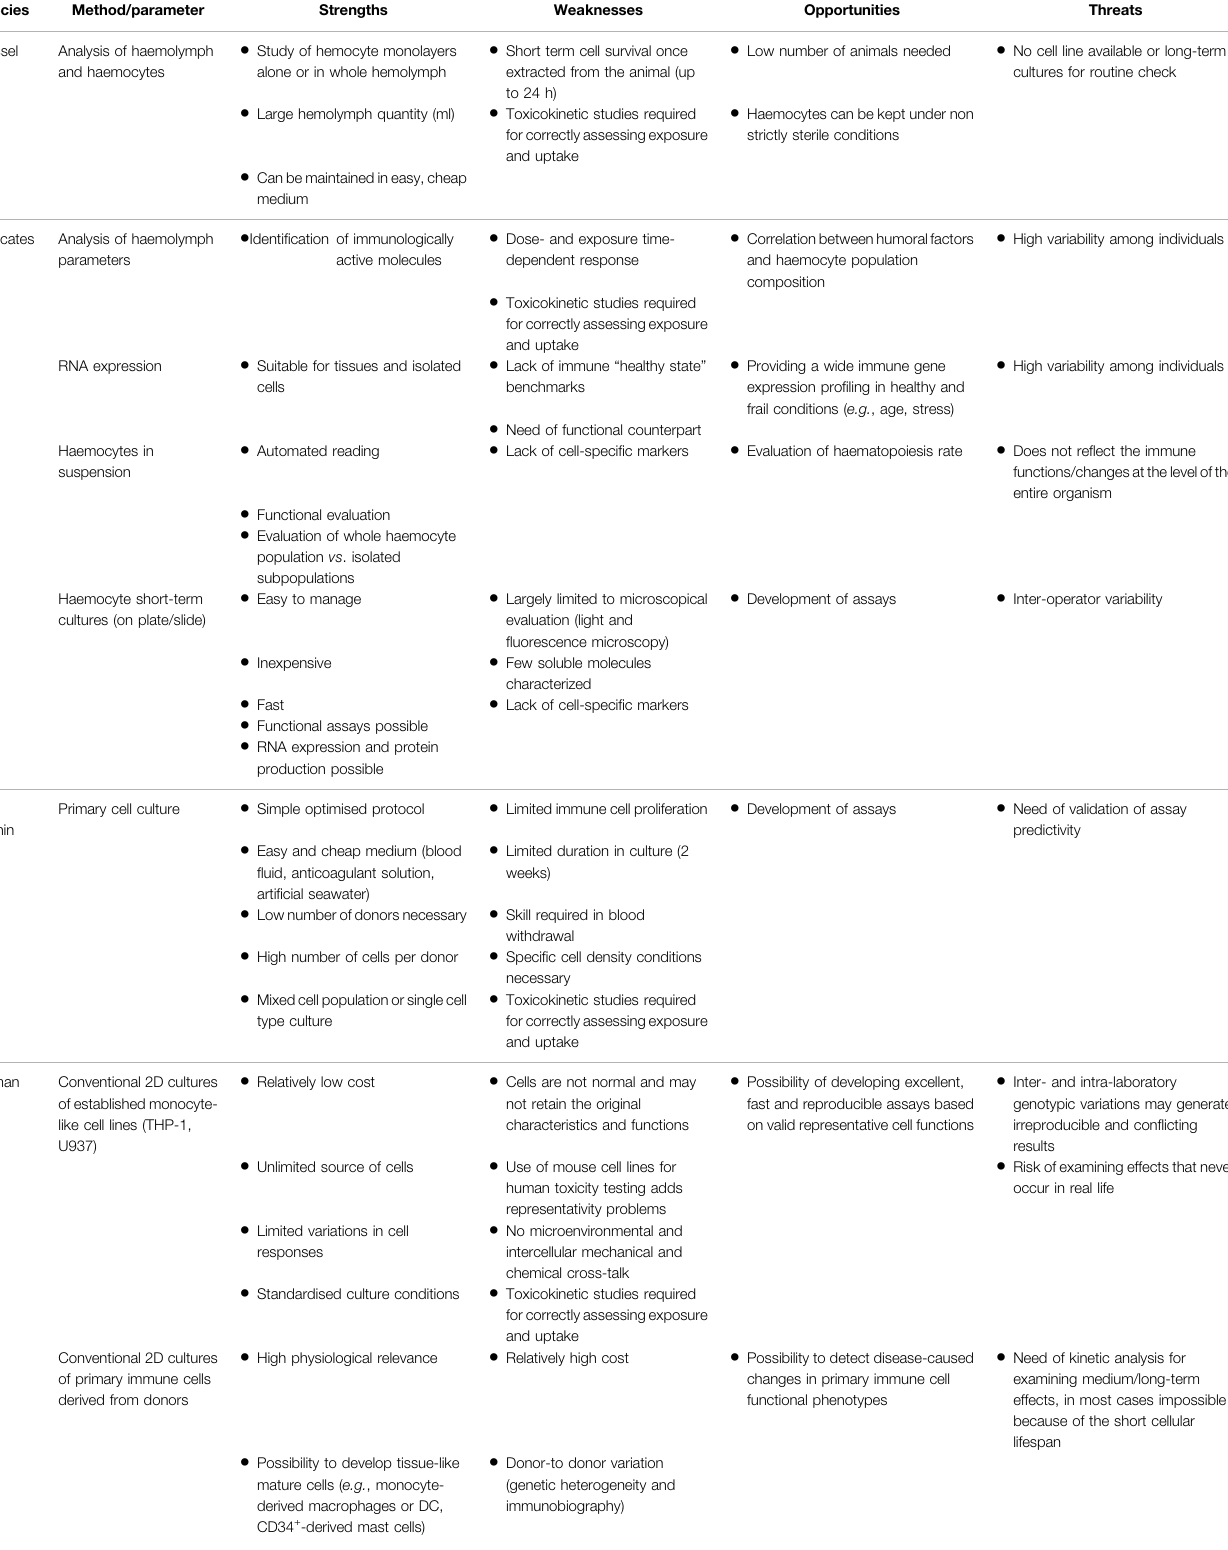
TABLE 3 | SWOT analysis of in vitro experimental methods in different animal models for immunotoxicity assessment.